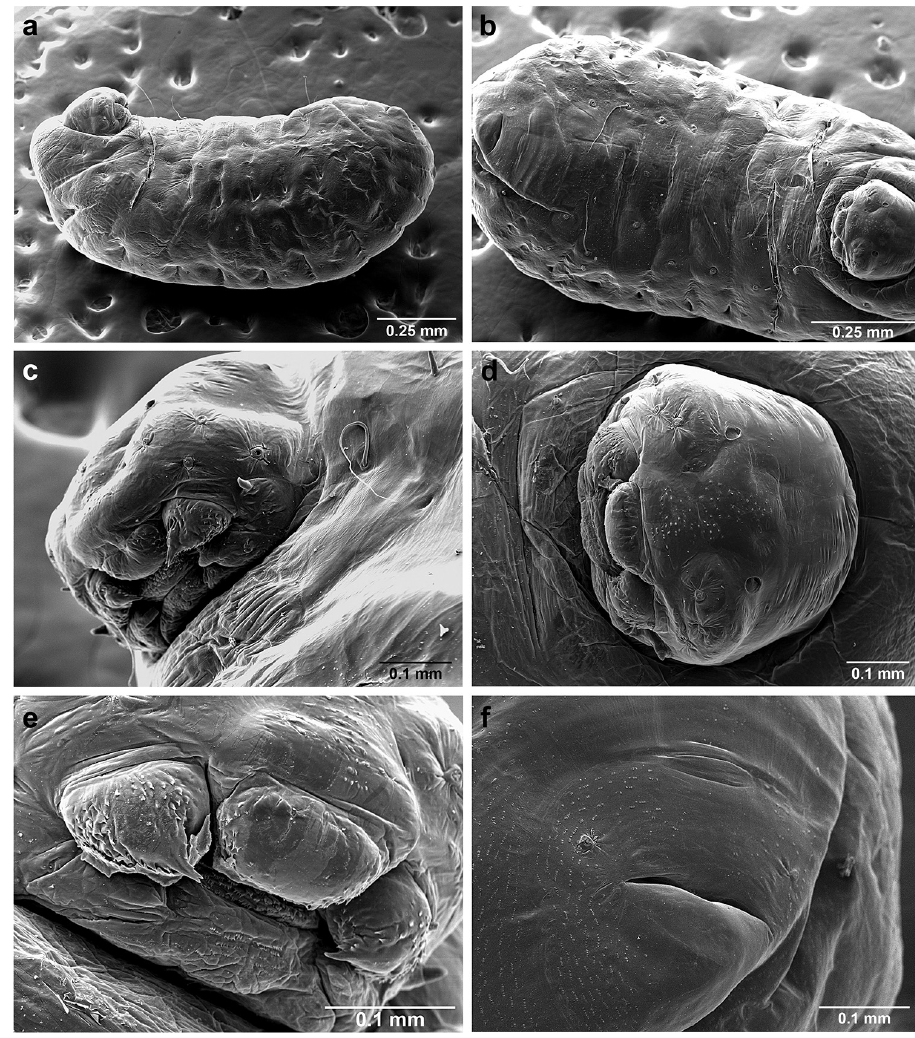
Figure 59. S. saussurei larva (USNMENT01126236), SEM images. a Lateral view b ventral view c head, frontolateral view d head, dorsal view e mouthparts f anal